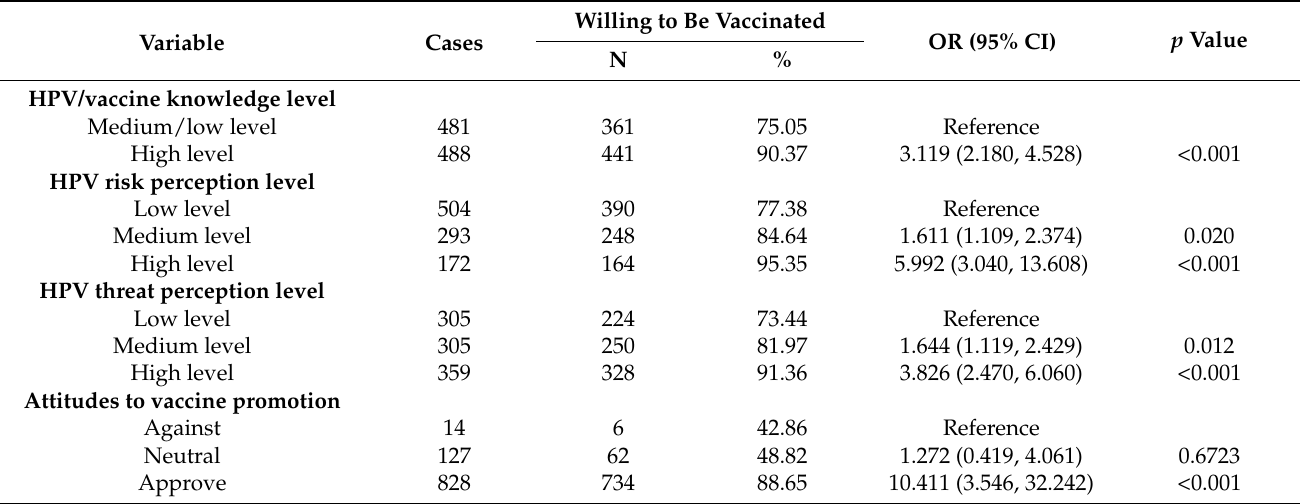
Table 3. Comparison of differences in HPV vaccination willingness among MSM with different knowledge, attitude, and risk/threat perception